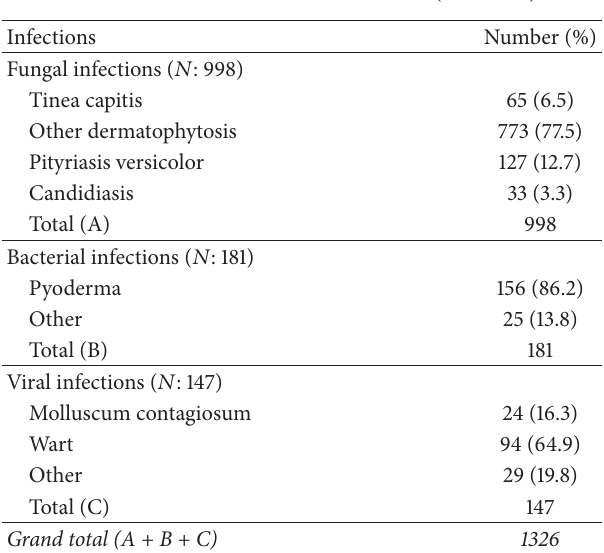
Table 4: Pattern of infectious dermatosis ( 𝑁 = 1326